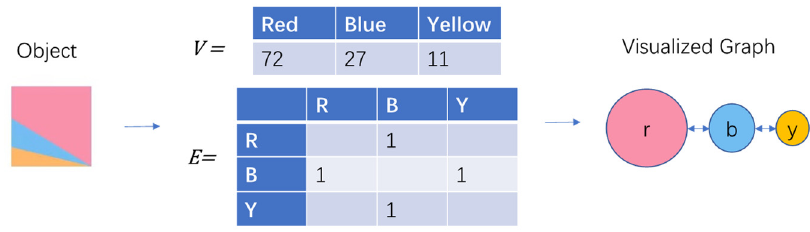
Figure 6. Color graph management.